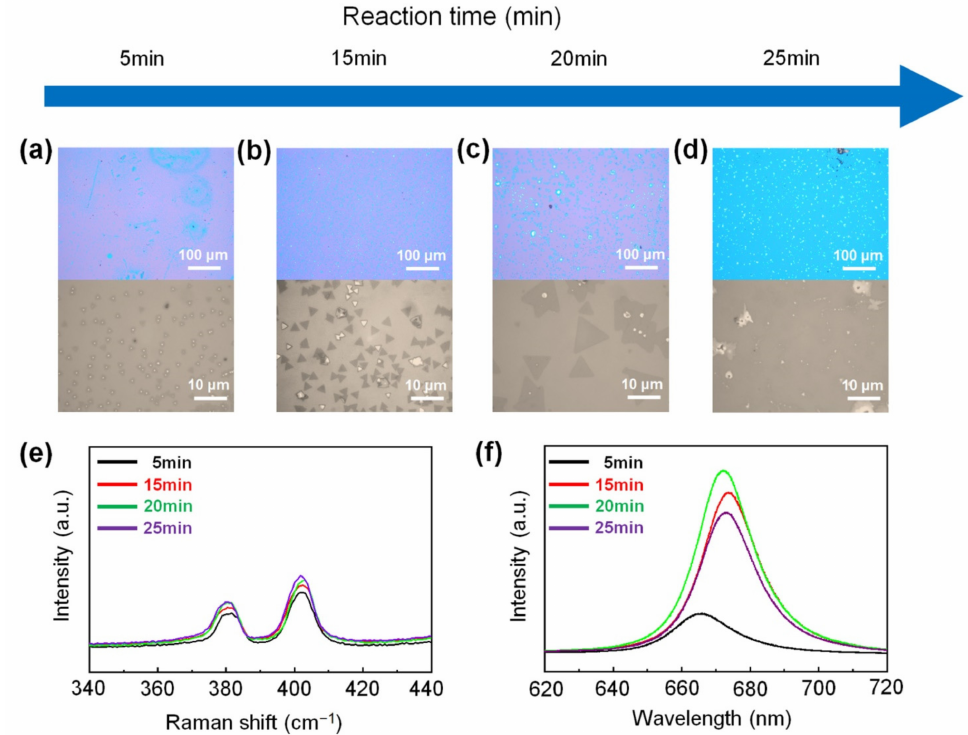
Figure 5. Growth process of monolayer MoS 2 in the carbon cloth-assisted CVD growth. Low- magnification and high-magnification optical images of monolayer MoS 2 synthesized at reaction times of ( a ) 5 min, ( b ) 15 min, ( c ) 20 min, and ( d ) 25 min, respectively. ( e ) Raman and ( f ) PL spectra of monolayer MoS 2 synthesized at reaction times of 5 min, 15 min, 20 min, and 25 min,